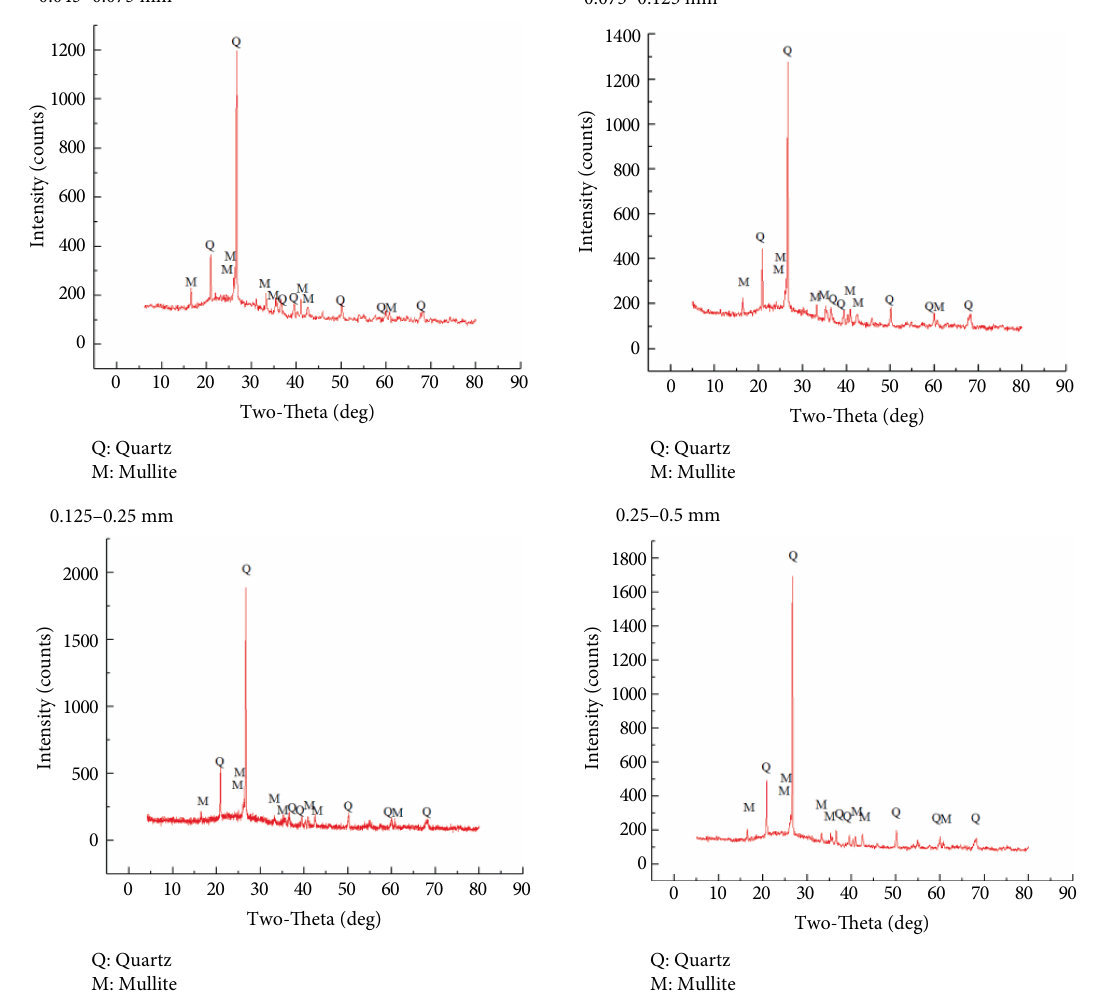
Figure 6: XRD pattern of fly ash with different particle sizes.